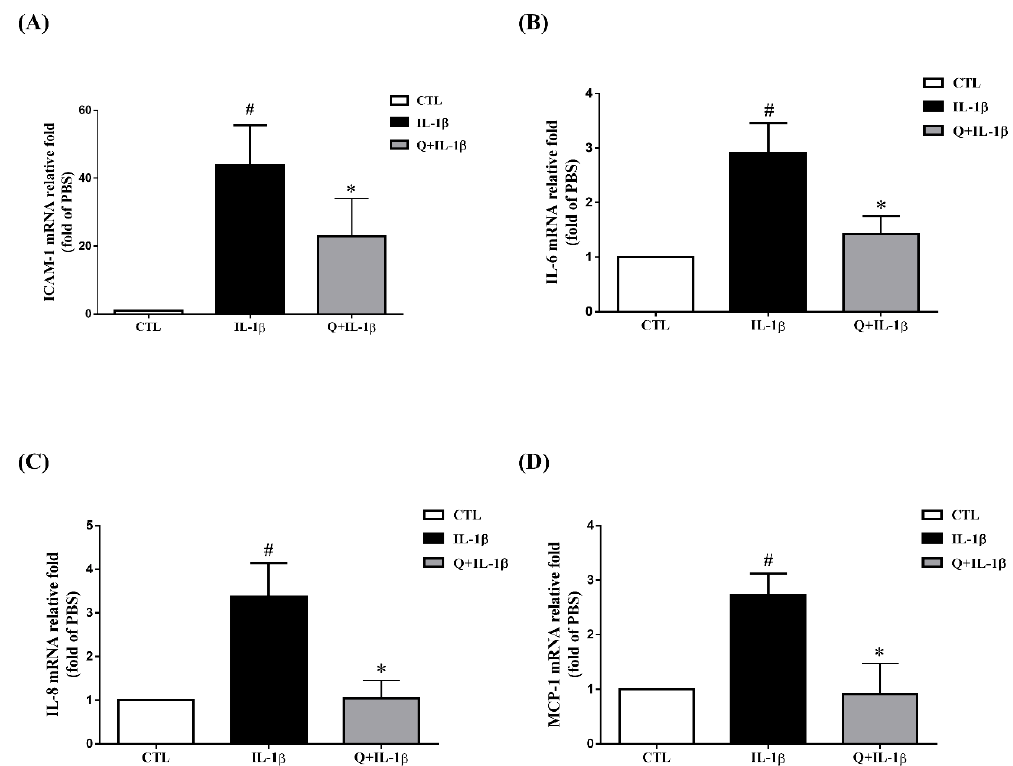
Figure 3. Quercetin attenuates the expression of ICAM-1, IL-6, IL-8 and MCP-1 mRNA in IL-1 β -stimulated ARPE-19 cells. ARPE-19 cells were pretreated with 20 µ M quercetin for 1 h before stimulation with 1 ng / mL IL-1 β for 4 h. Reverse Transcription-Quantitative Polymerase Chain Reaction (RT-qPCR) was used to determine the fold changes in ( A ) ICAM-1, ( B ) IL-6, ( C ) IL-8 and ( D ) MCP-1 gene expression with β -actin as an internal control. The data are expressed as mean ± SD of three independent experiments. # p < 0.05 versus control cells. * p < 0.05 versus IL-1 β -stimulated cells.